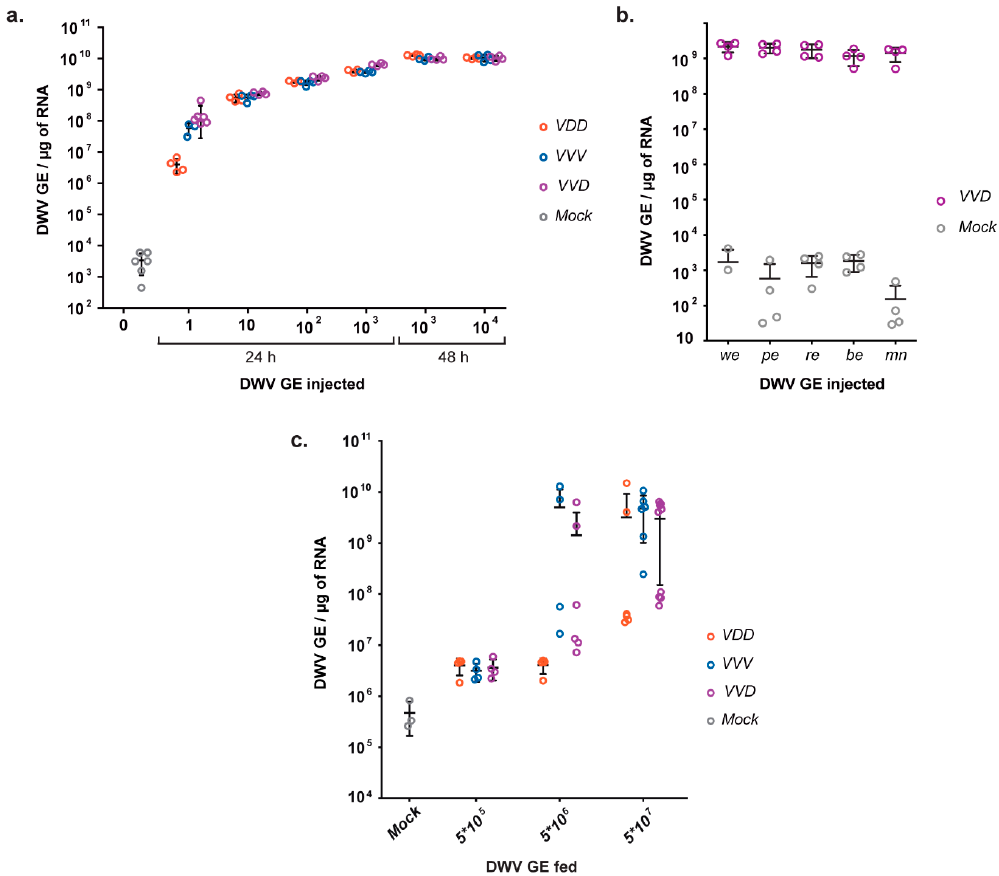
Figure 2. Inoculation of the honey bee brood with RG-DWV. ( a ) RT-qPCR analysis of DWV level in honey bee pupae (injected at white-eyed stage) 24 h and 48 h post-injection with di ff erent amounts of DWV variants, “Mock”—uninoculated pupae; ( b ). RT-qPCR analysis of honey bee pupae, injected with 10 2 GE of VVD at di ff erent stages of pupal development: white-eyed (“we”), pink-eyed (“pe”), red-eyed (“re”), blue-eyed (“be”), and at the start of full melanisation (“mn”). Pupae were sacrificed 24 h post-inoculation; ( c ) RT-qPCR analysis of DWV accumulation levels in honey bee larvae 48 h after feeding with DWV variants at di ff erent concentrations. Each value corresponds to an individual pupa or larva analysed, and error bars show mean ±